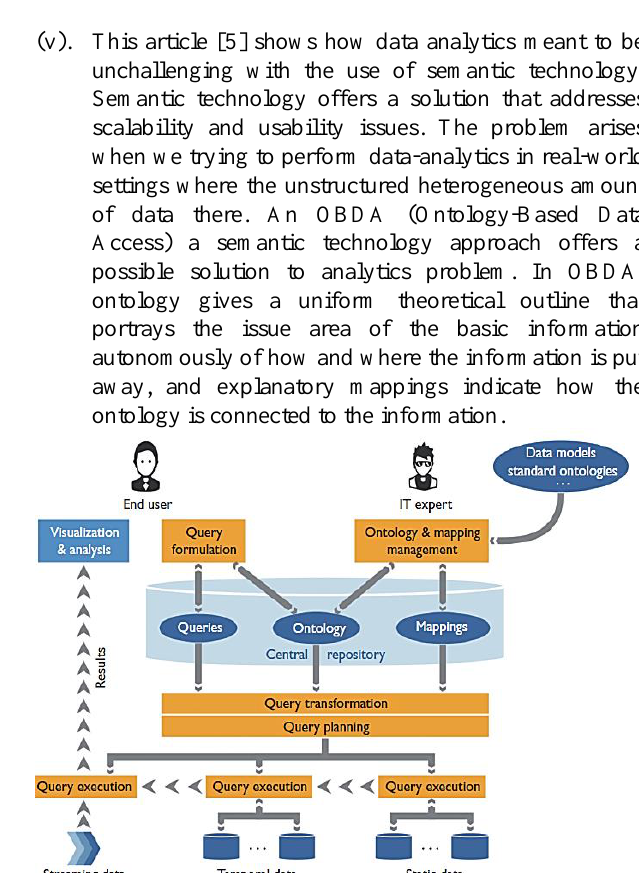
Figure 4. IC (Intellectual Capital) mining system